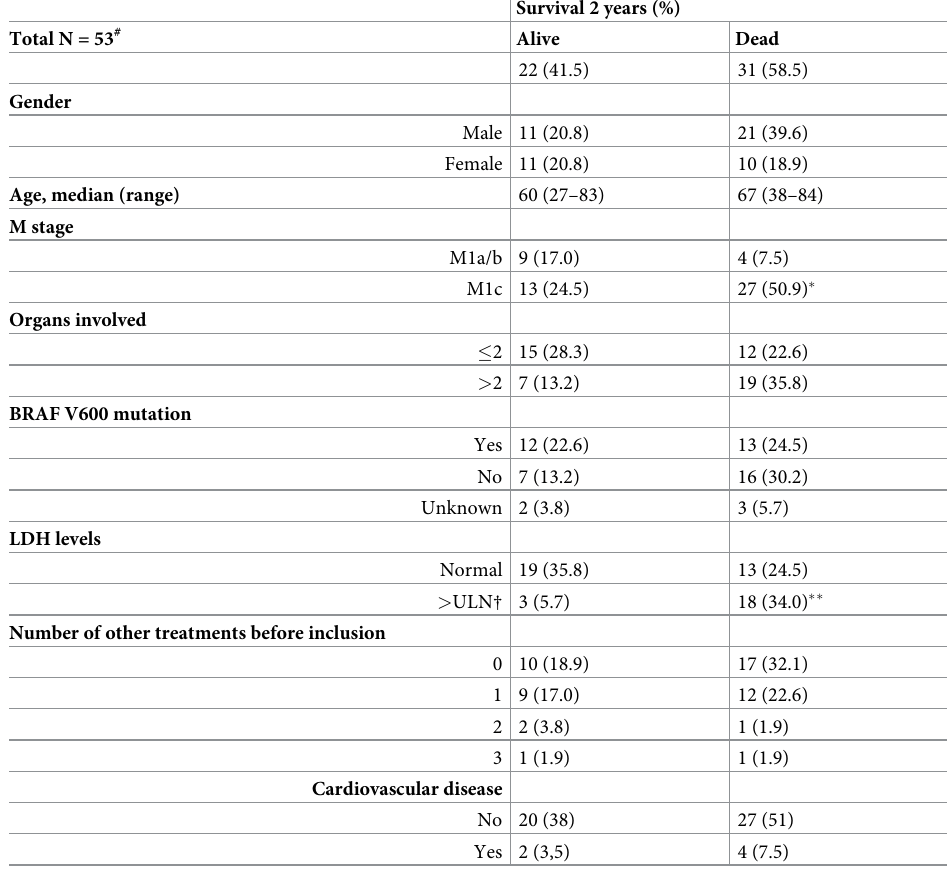
Table 2. Clinical characteristics of the study population stage IV disease according to